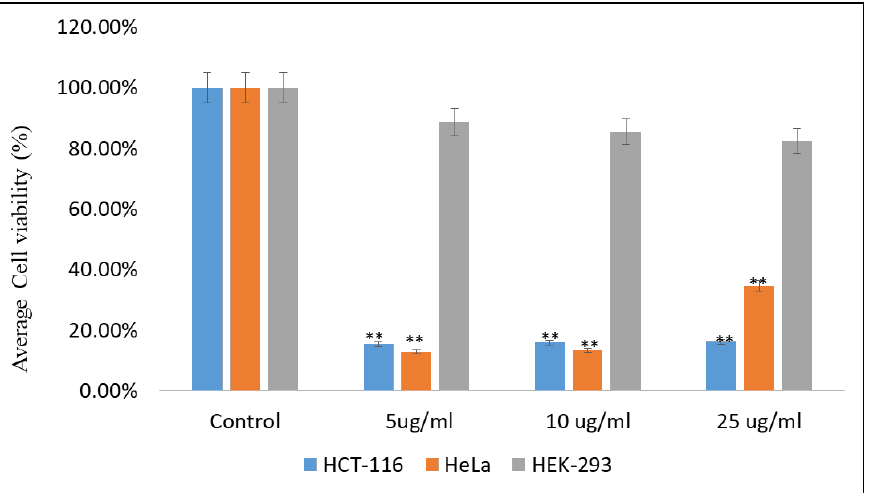
Figure 16. Effects of emodin on HeLa, HCT-116 and HEK-293 cells cell viability assessed by MTT assay. ** p < 0.01.